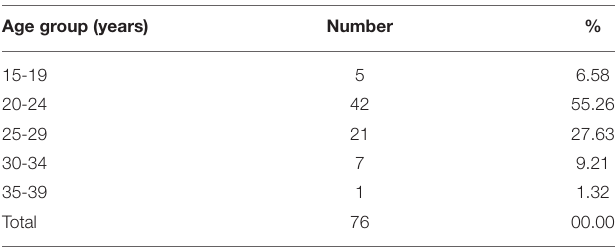
TABLE 2 | Age of the women participating in FGD, Nashik, India, 2018.